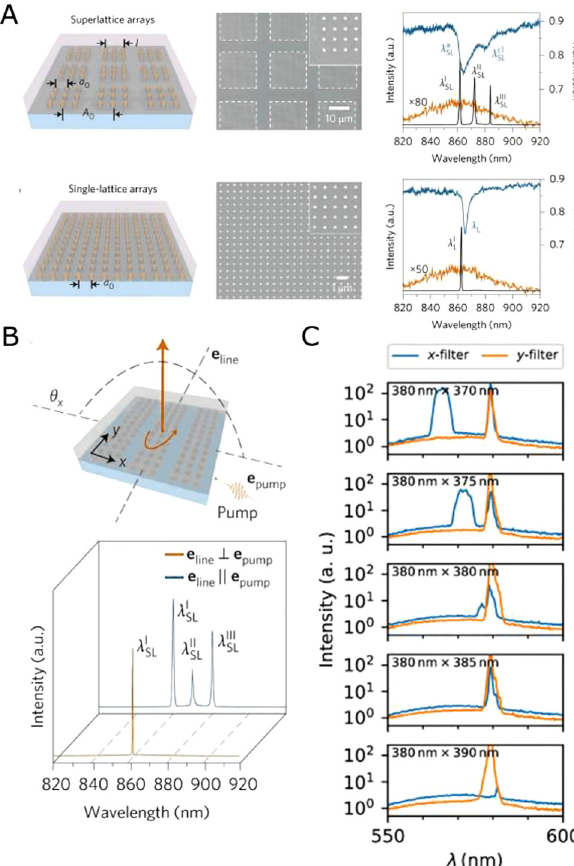
Figure 10: Switching between single and multimodal operation. (A) Schematic of superlattice and single lattice arrays (left), their SEM images (middle), and their corresponding spectra (right). The superlattice exhibits multimodal lasing (top, right), whereas the single lattice demonstrates single mode lasing (bottom, left) as evidenced by the lasing spectra shown as black solid curves in both figures. (B) Schematic of altered superlattice (top) and its output lasingspectra(bottom).Ifthepumpdirectionisperpendiculartothe lattice, the array operates in single mode lasing regime, whereas when the pump is parallel to the lattice direction, multimodal lasing is observed.(A) and (B)adaptedand reprintedfrom a study by Wang et al. [70] with permission. (C) Experimental emission spectra for Ni nanodiskarrayforvaryinglatticeperiodicities.Thepresenceof both x and y polarized modes con fi rms multimode lasing for some periodicities.AdaptedandreprintedfromastudybyPourjamaletal. [71] with